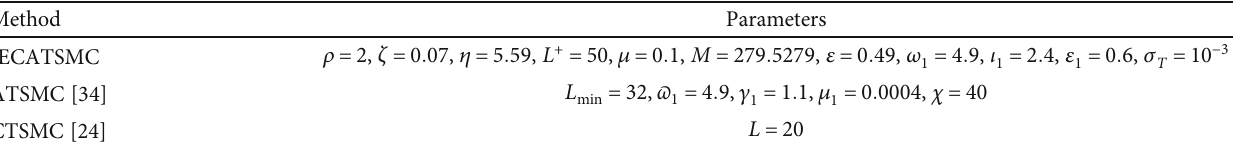
Table 2: Control parameters of the three algorithms.